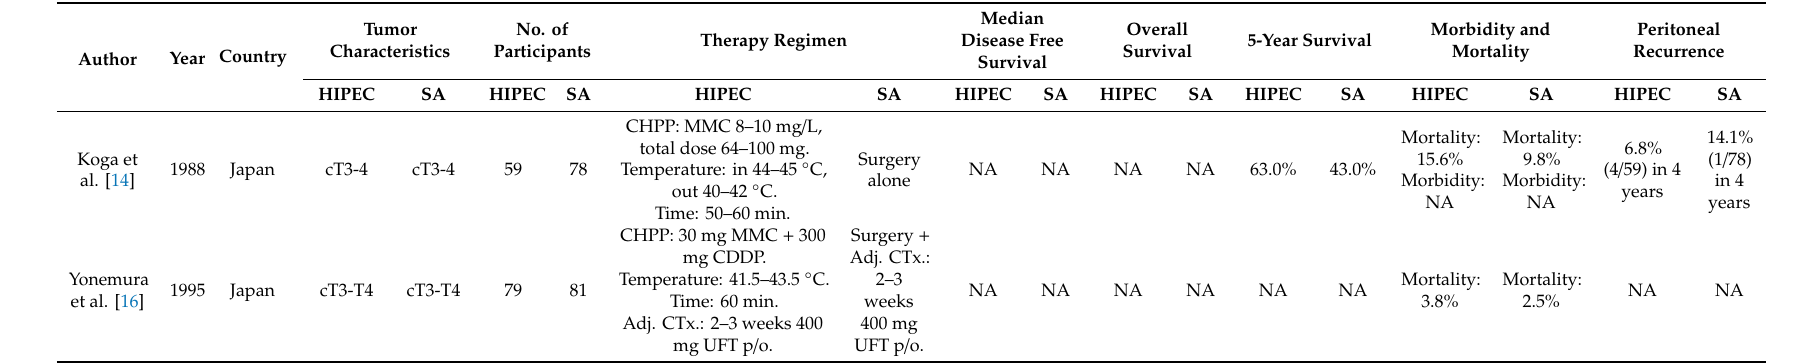
Table 4. Non-randomised comparative